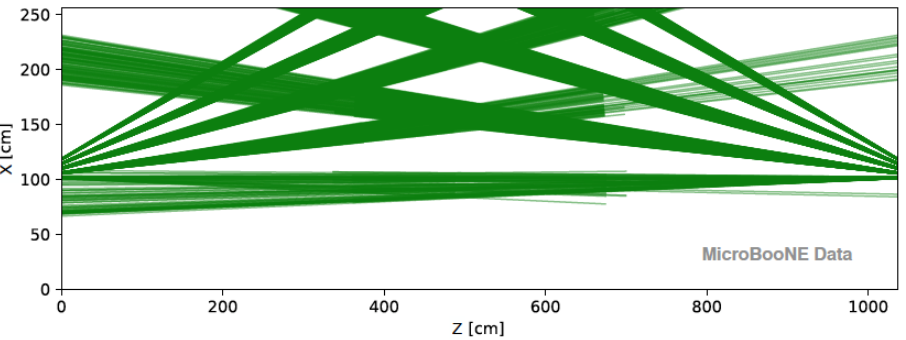
Figure 6. Reconstructed laser tracks in the MicroBooNE detector. From